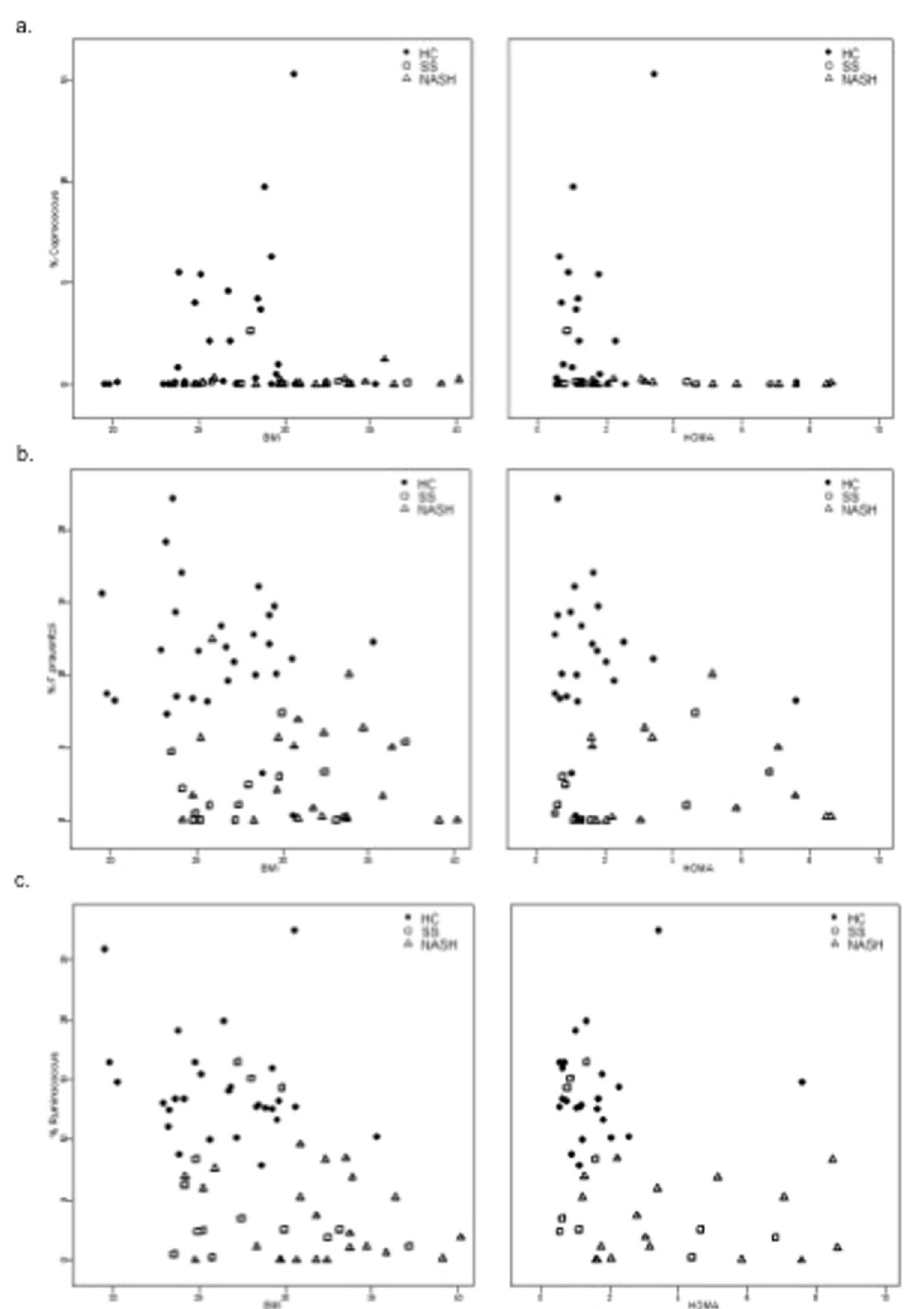
Figure 3. Scatterplots illustrating relationship between relative abundance of relevant bacterial taxa by qPCR, diagnosis and body mass index (left panel), and homeostasis model assessment estimated insulin resistance (HOMA-IR, right panel) ( a ) Coprococcus ; ( b ) F. prauznitzii ( c ) Ruminococcus .